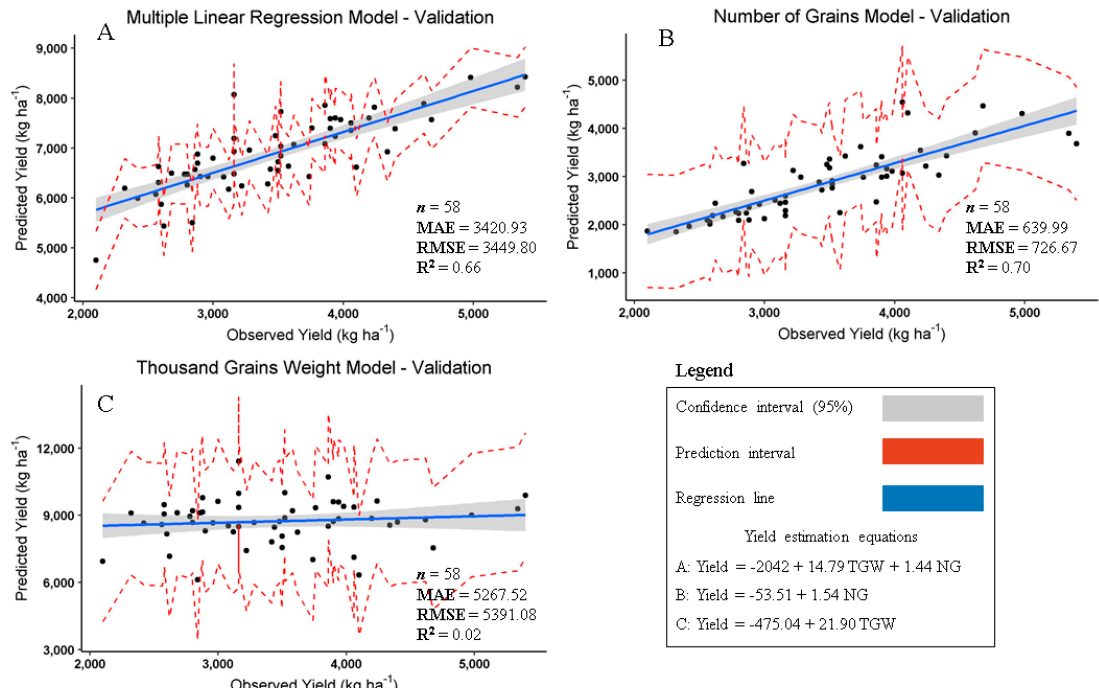
Figure 3. Scatterplot of soybean observed and predicted yields (kg ha − 1 ) applied to validation dataset. ( A ) Yield estimation based on thousand grains weight (TGW in g 1000 grains − 1 ) and number of grains (NG in grains m − 2 ), ( B ) yield estimation as function of number of grains (NG in grains m − 2 ) and ( C ) yield estimation as functions of thousand grains weight (TGW in g 1000 grains − 1 ). n = number of observations; MAE = mean absolute error (kg ha − 1 ); RMSE = root mean squared error (kg ha − 1 ); R 2 = multiple R-squared; Yield = soybean yield (kg ha − 1 ); TGW = thousand grains weight (g 1000 grains − 1 ); NG = number of grains (grains m − 2 ).